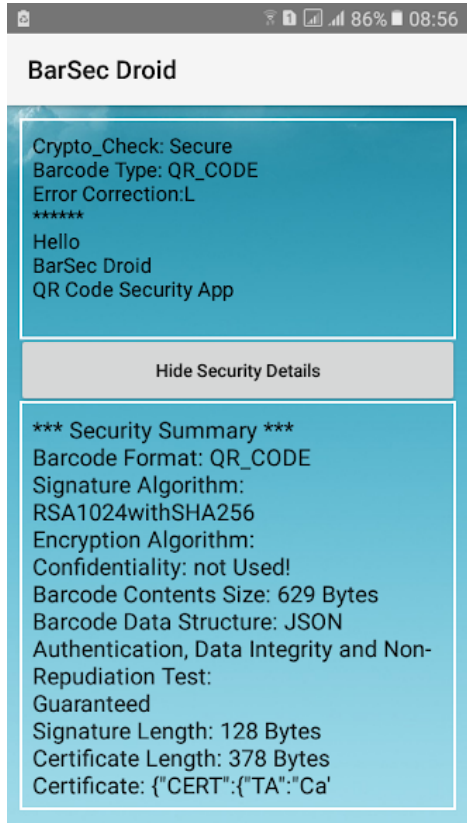
Figure 3. Screenshot of a BarSec Droid Android